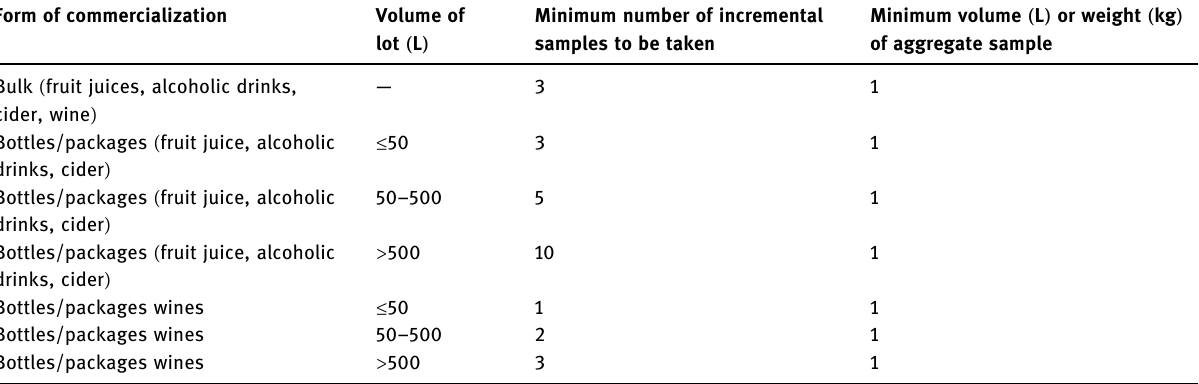
Form of commercialization